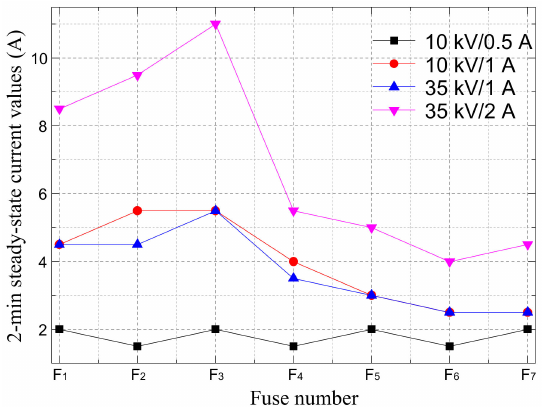
Figure 3. The 2-min steady-state current values of the 10/35 kV VT